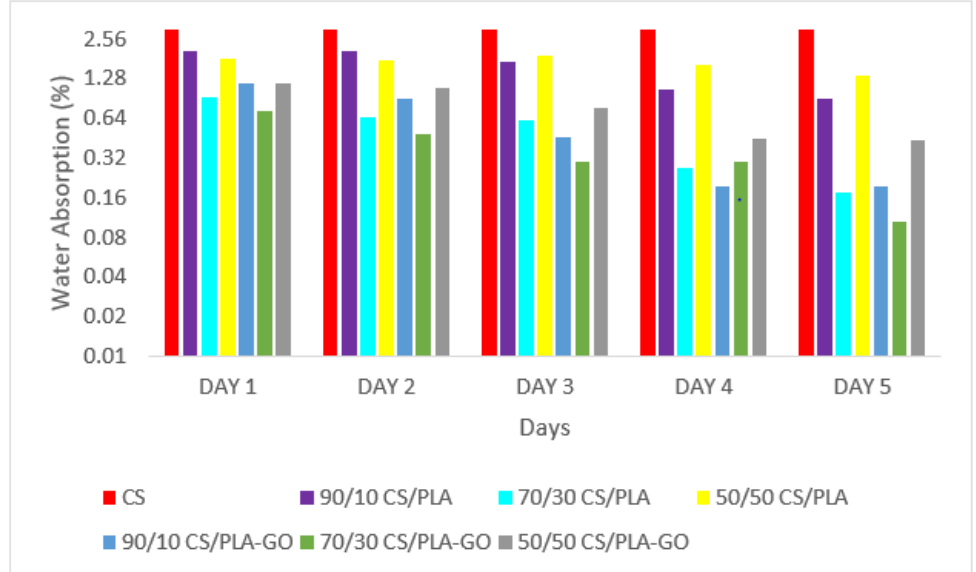
Figure 9. Water absorption of CS and CS/PLA with and without GO composites.